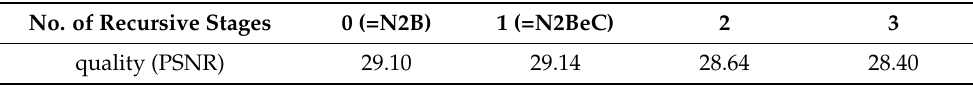
Table 3. Effects of successive recursive learning stages.